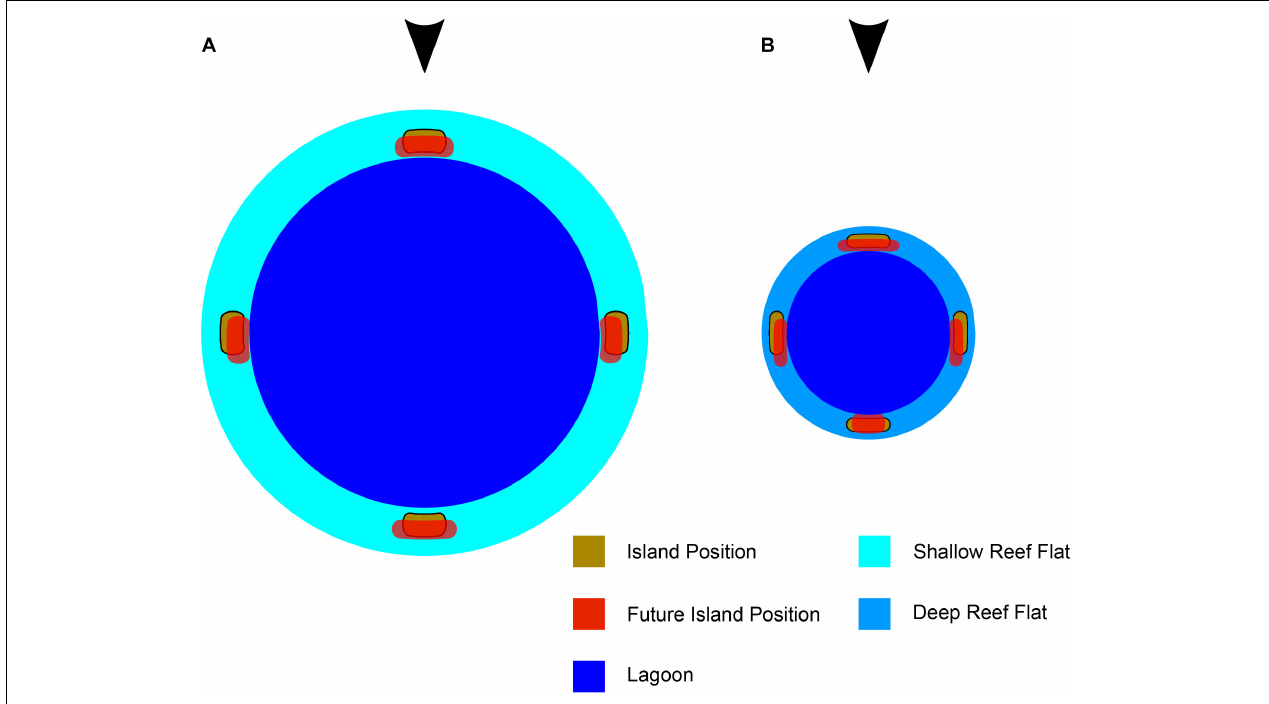
FIGURE 5 | Schematic atoll island shoreline response to SLR, with waves approaching from the top of the diagram. (A) Relatively resistant atoll (shallow, wide fringing reef flat; large atoll; wide islands). (B) Relatively susceptible atoll (deep, narrow fringing reef flat; small atoll, narrow islands). Initial island positions are shown in gold, with future positions overlain in